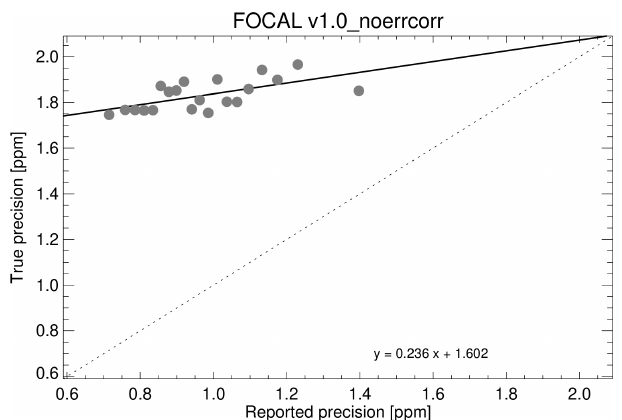
Figure 19. Comparisons of the (binned) original XCO 2 errors (re- ported precision without correction) of the GOSAT-FOCAL product with estimated errors based on collocated TCCON data (true preci-